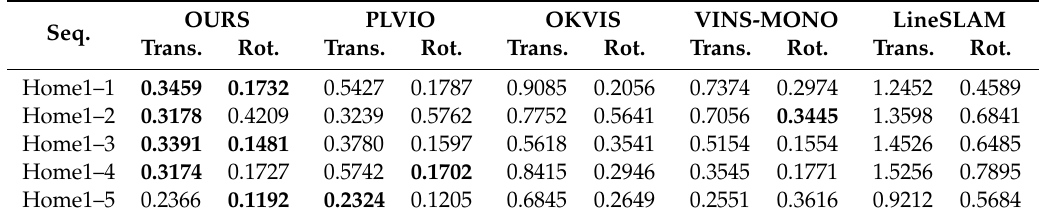
Figure 10. The comparative absolute rotation errors. The first two rows show the absolute orientation error in the Handheld With More Rotation and Wheeled Slow Experiment, respectively, where the left results ( a , c ) are from our system and right ( b , d ) are from PLVIO. The last row shows the absolute rotation error of our system and PLVIO, where the left results ( e ) are the Handheld With More Rotation Experiment and the right ( f ) is Wheeled Slow Experiment. Table 2. The root mean square error (RMSE) of translation and rotation on the home scene dataset in